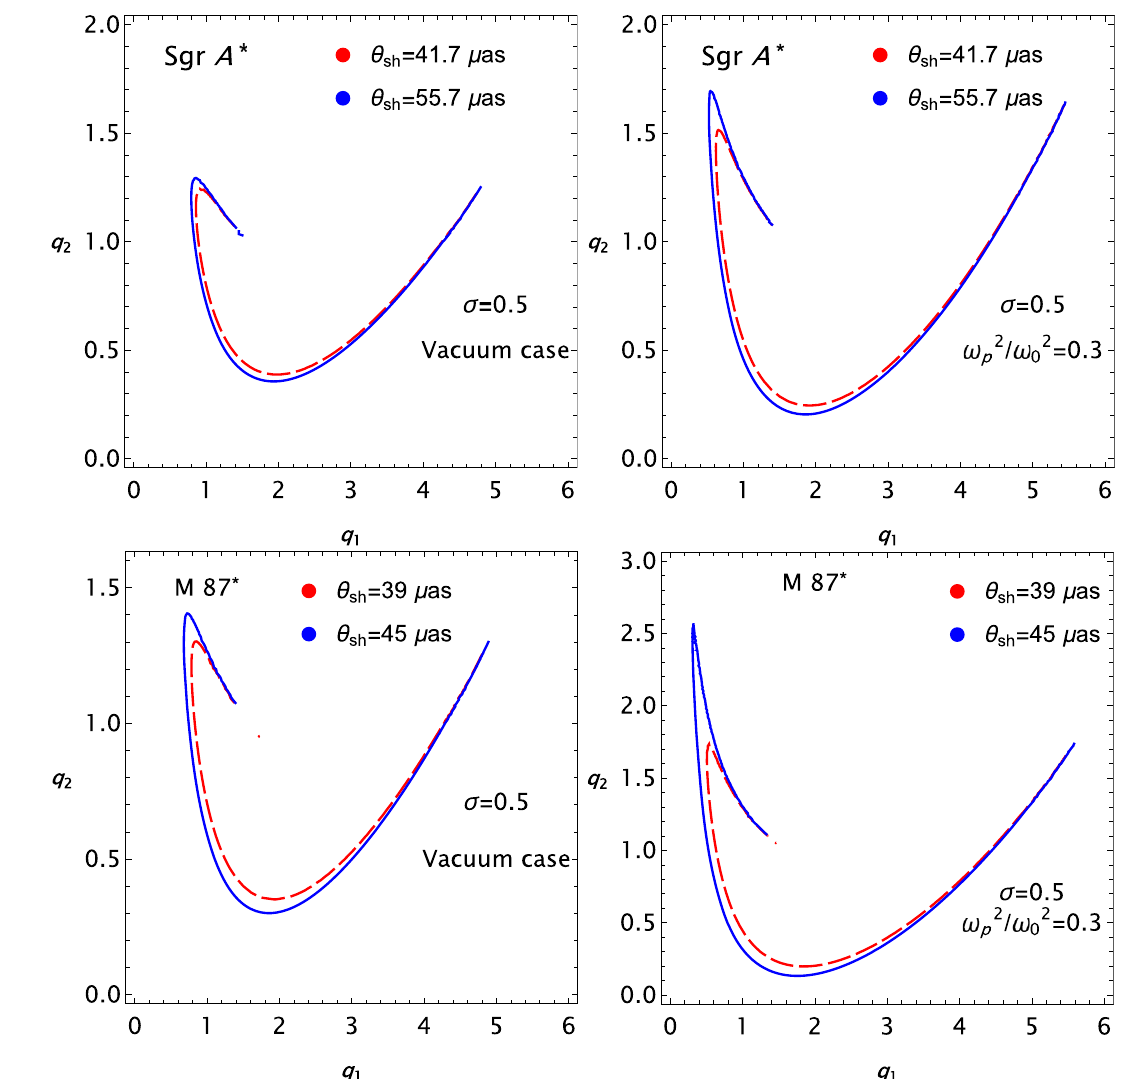
Fig. 13 Constraints on possible values of the parameters q 1 and q 2 for σ = 0 . 5. Here, we used the observational angular size of SMBHs M87* and SgrA* as θ sh = 42 ± 3 µ as and θ sh = 48 . 7 ± 7 µ as, respectively